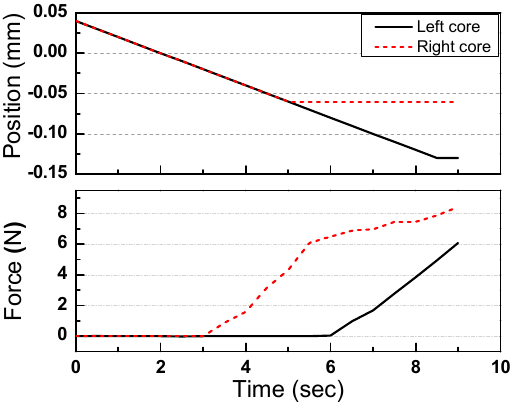
Figure 14. Test results under the reference force of 5 N and movement of 10 μ m.